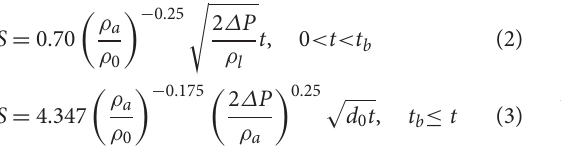
where ρ a is in-cylinder gas density, ρ 0 is reference density of air at SATP, ρ l is the density of liquid fuel, d 0 is injector hole diameter and 1 P is the pressure difference between injection pressure and in-cylinder pressure. Before t b is reached, spray tip penetration S is a linear function of time after injection t , given in Equation (2). After breakup of the spray, the tip penetration is represented as a function of √ t , given in Equation